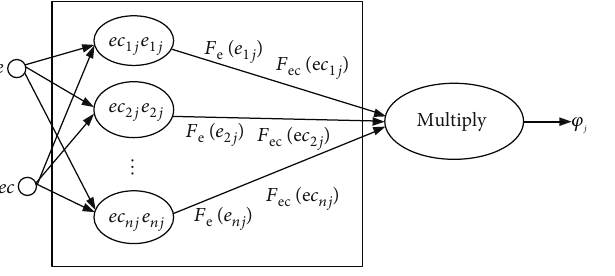
Figure 9: The inner structure of the i th node.